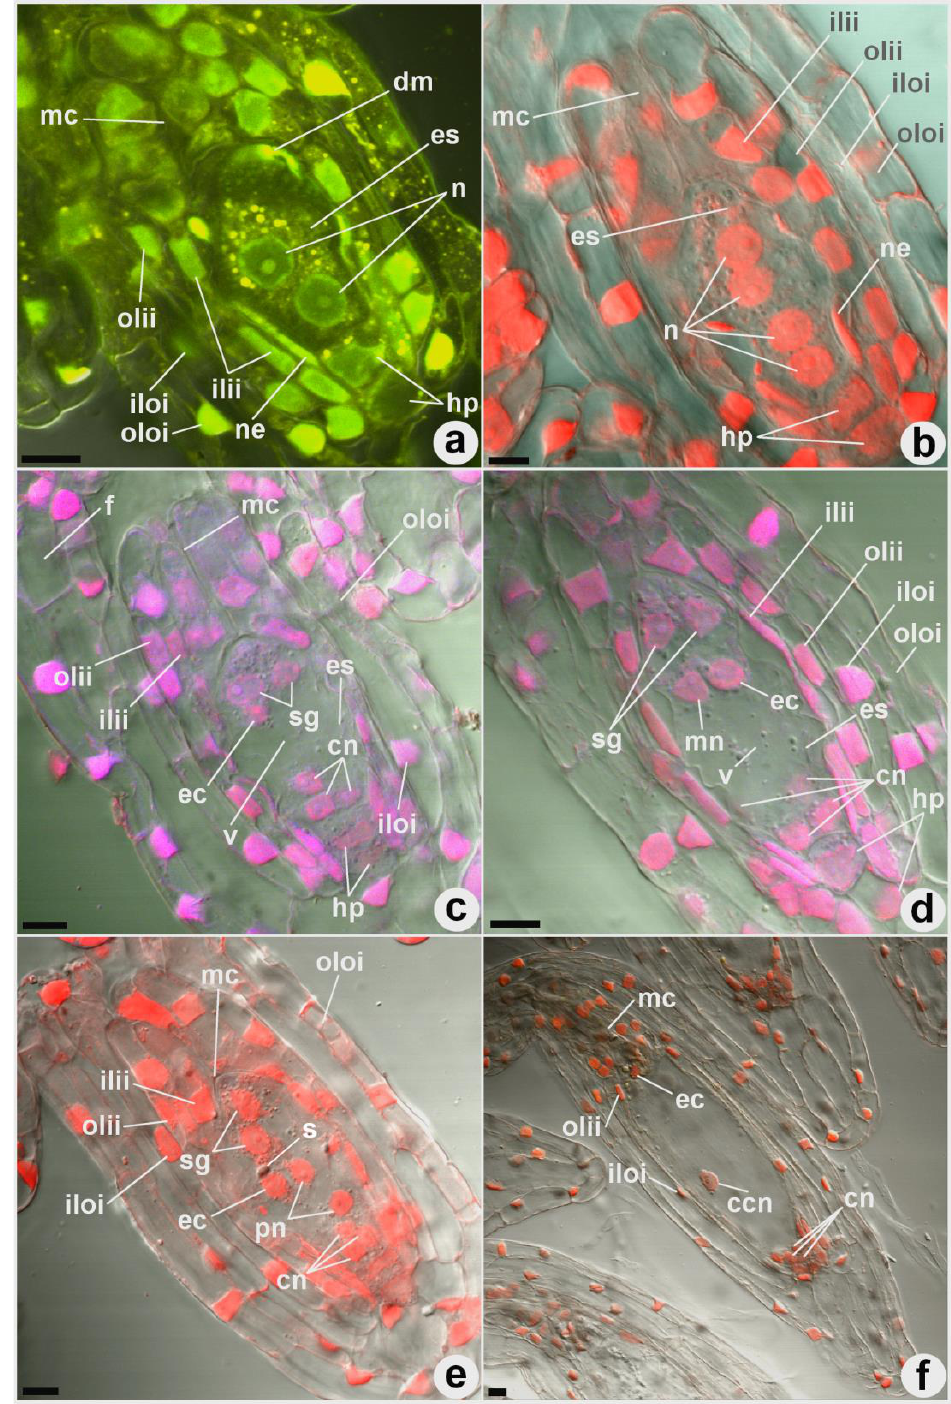
Figure 2. Megagametogenesis and formation of the mature embryo sac of C. speciosa subsp. fimbriata : used confocal laser scanning microscopy ( a ) First mitotic division of a functional megaspore (BRB); ( b ) Second mitotic division of a functional megaspore (PI); ( c ) 6-nuclear embryo sac (PI); ( d ) 8-nuclear embryo sac with a large vacuole (PI); ( e ) 8-nuclear mature embryo sac at the stage of fertilization (PI); ( f ) embryo sac at the stage of early embryogenesis (PI) Abbreviations: ccn, central cell nucleus; cn, chalazal nuclei; dm, degeneration megaspores; ec, egg cell; es, embryo sac; hp, hypostase; ilii, inner layer of inner integument; iloi, inner layer of outer integument; mc, micropyle; mn, micropylar nuclei; n, nucleus; ne, nucellar epidermis; olii, outer layer of inner integument; oloi, outer layer of outer integument; pn, polar nuclei; sg, synergids; v, vacuole; s, sperm Scale bars = 10 µ